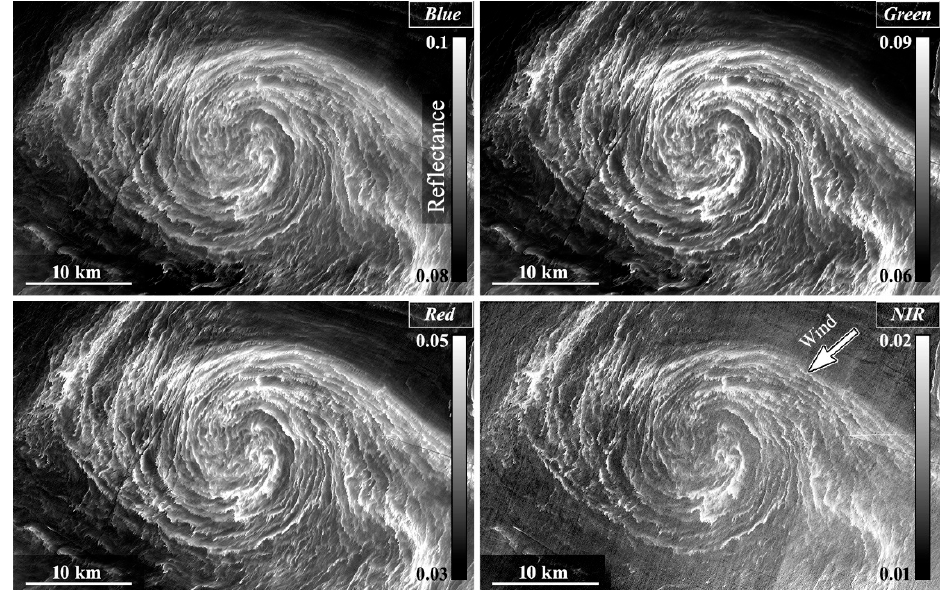
Figure 2. The studied fragment of the Sentinel 2A MSI scene in different bands. An arrow shows the wind direction.